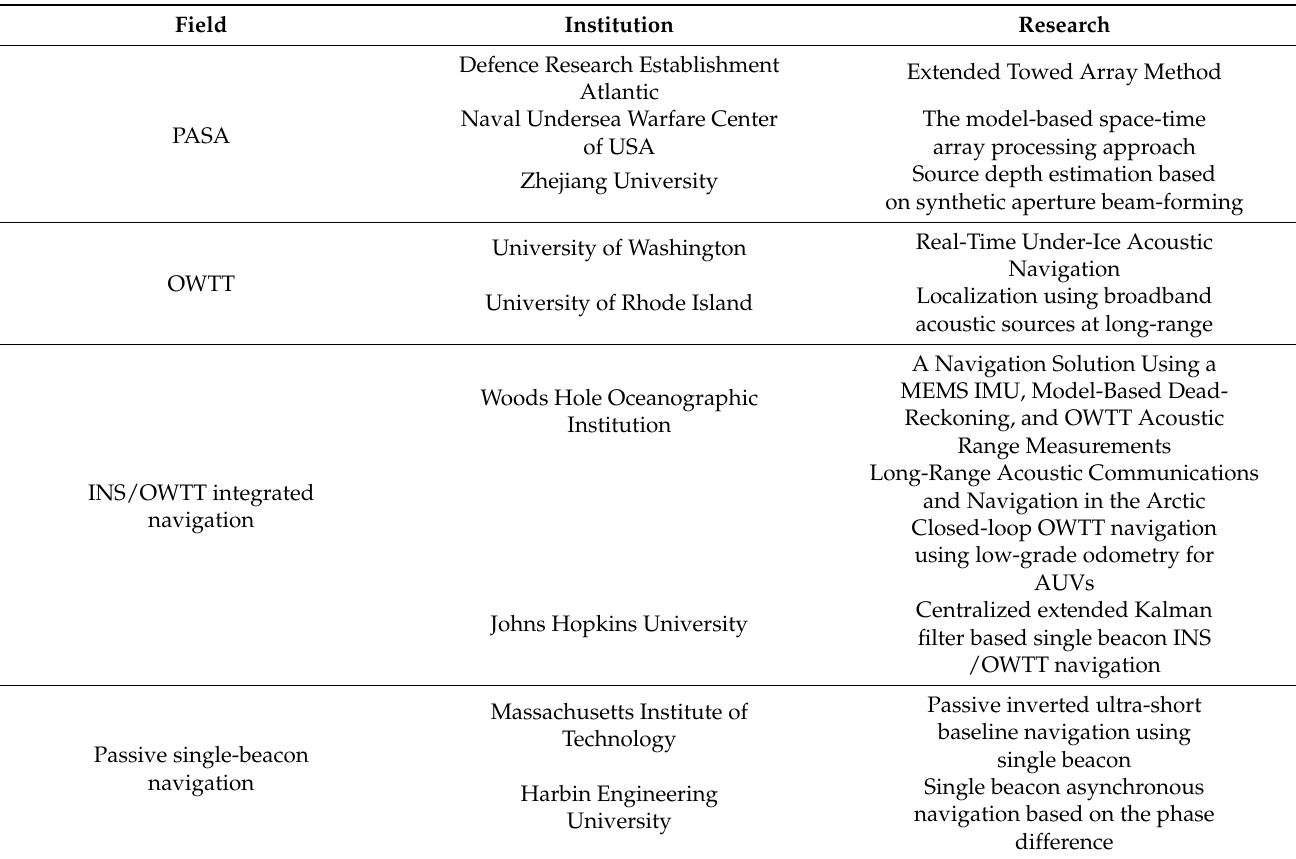
Table 1. Some related studies about underwater detection and